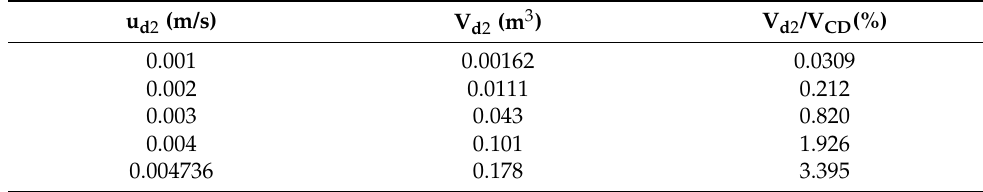
Table 11. Volume fraction of dead region in the discharging chamber under different critical velocities. u d 2 (m/s) V d 2 (m 3